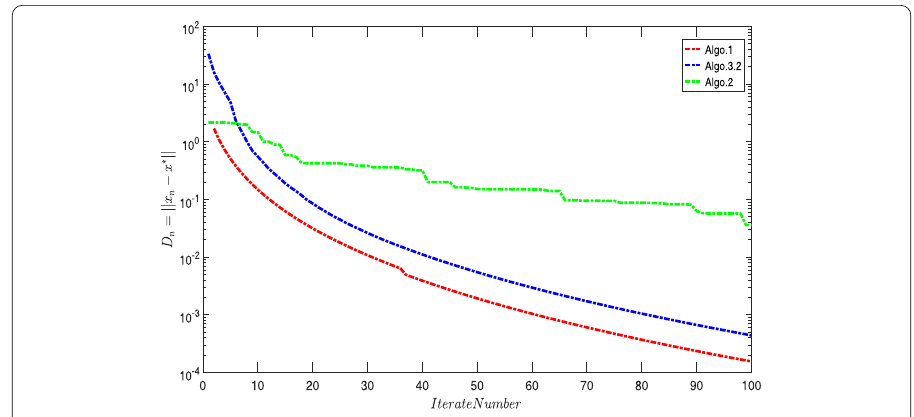
Figure 1 Experiment with m = 10 for Example 4.2